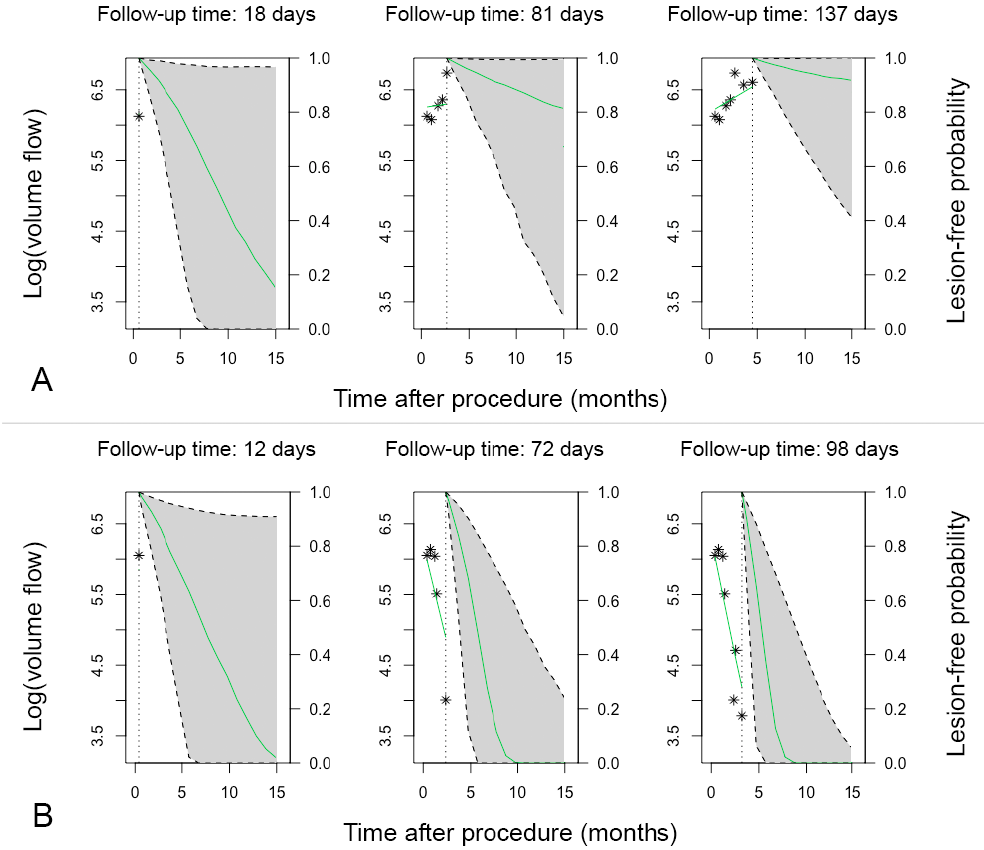
Figure 3. Illustration of a retrospectively estimated lesion-free probability by the developed model. The green line represents the hazard for stenosis or occlusion with corresponding 95% confident intervals in gray. The asterisks represent the measured VF values. ( A ) Illustration of the estimations of a patient who remained lesion-free after a reintervention at 58 days of follow-up. ( B ) In this patient, multiple stenoses were treated at 72 and 130 days of follow-up.